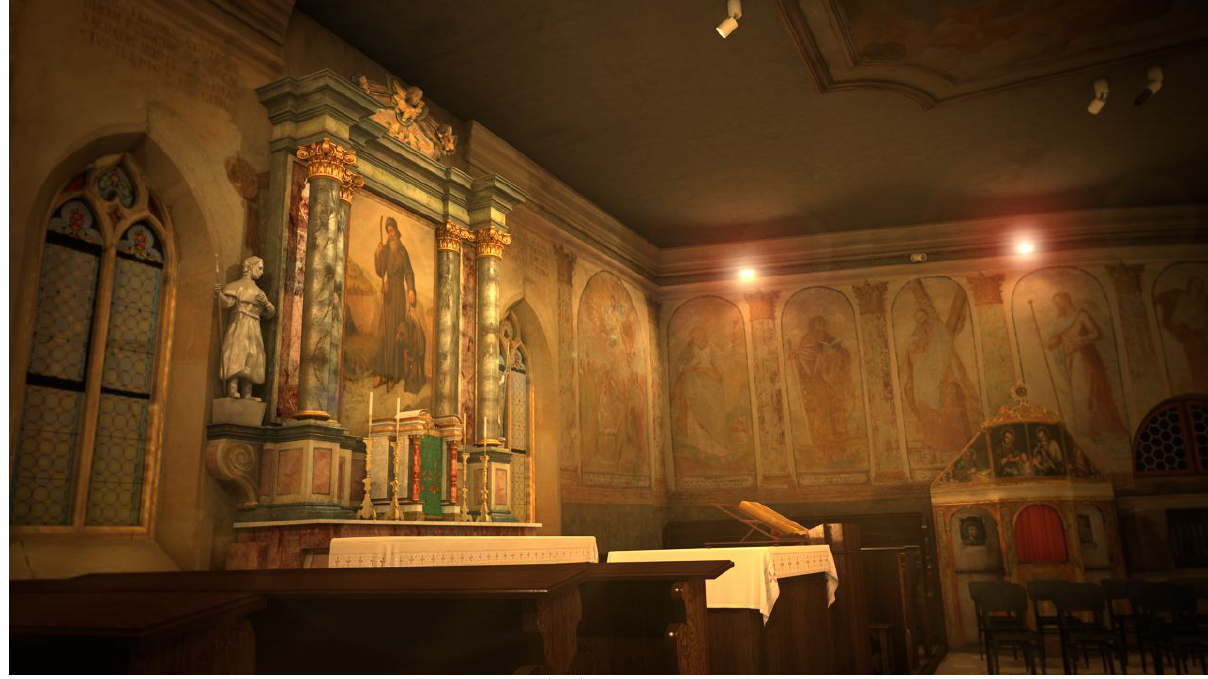
Figure 6. San Romedio Chapel, San Romedio hermitage (TN): digital photorealistic image exported from the 3D figurative model (authors: Stefano Longo, Lucia